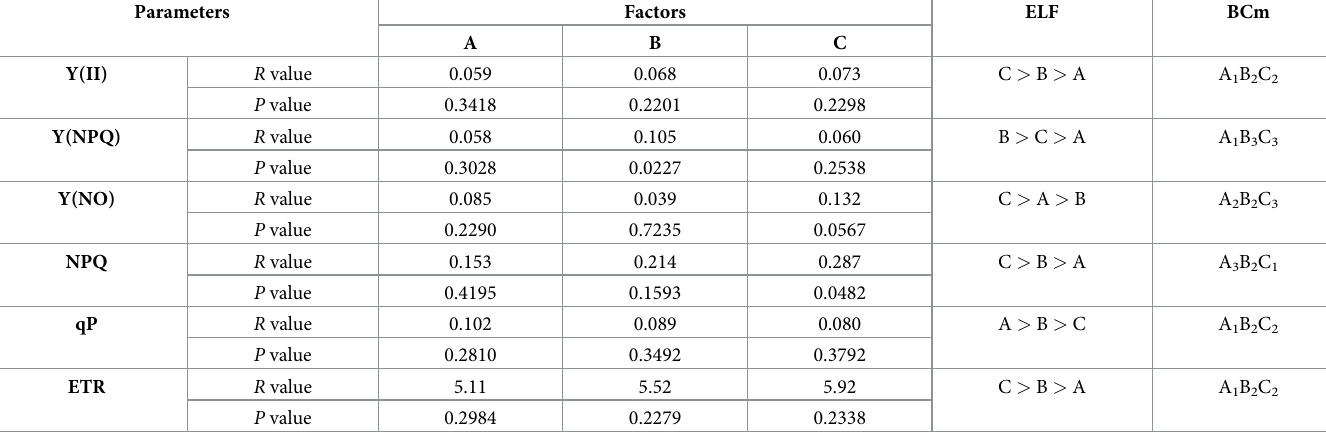
Range value ( R )–the range of difference between the maximum and minimum average; ( P -value)–ANOVA analysis of variance; ELF–The most influential level factors on the parameter gradually; BCm–The best level combination for each